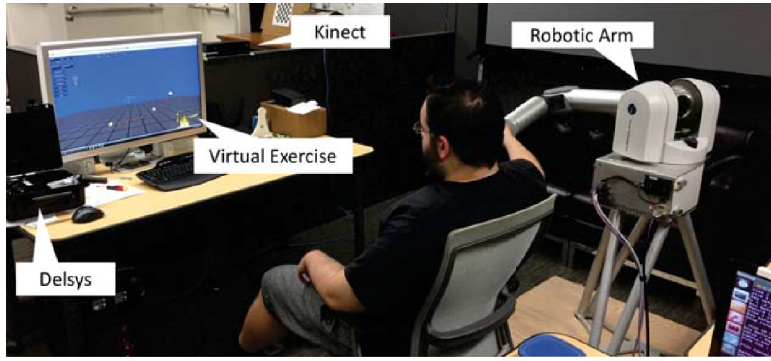
Figure 11. Game-based upper-limb robotic rehabilitation